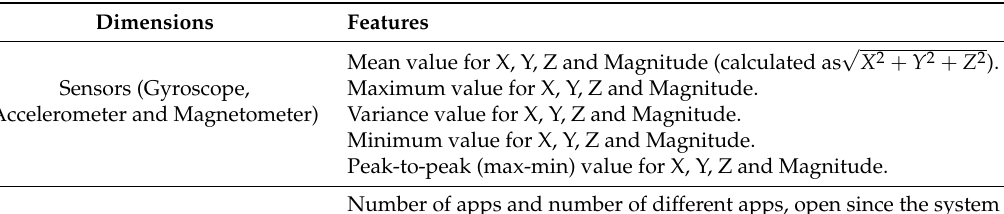
Table 5. List of initial